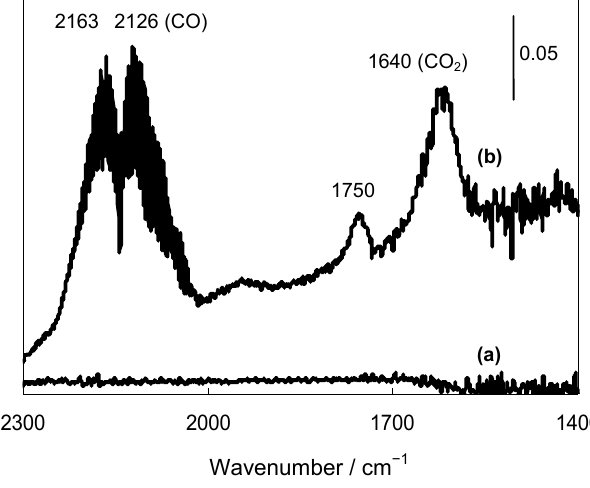
O adsorption at 298 2